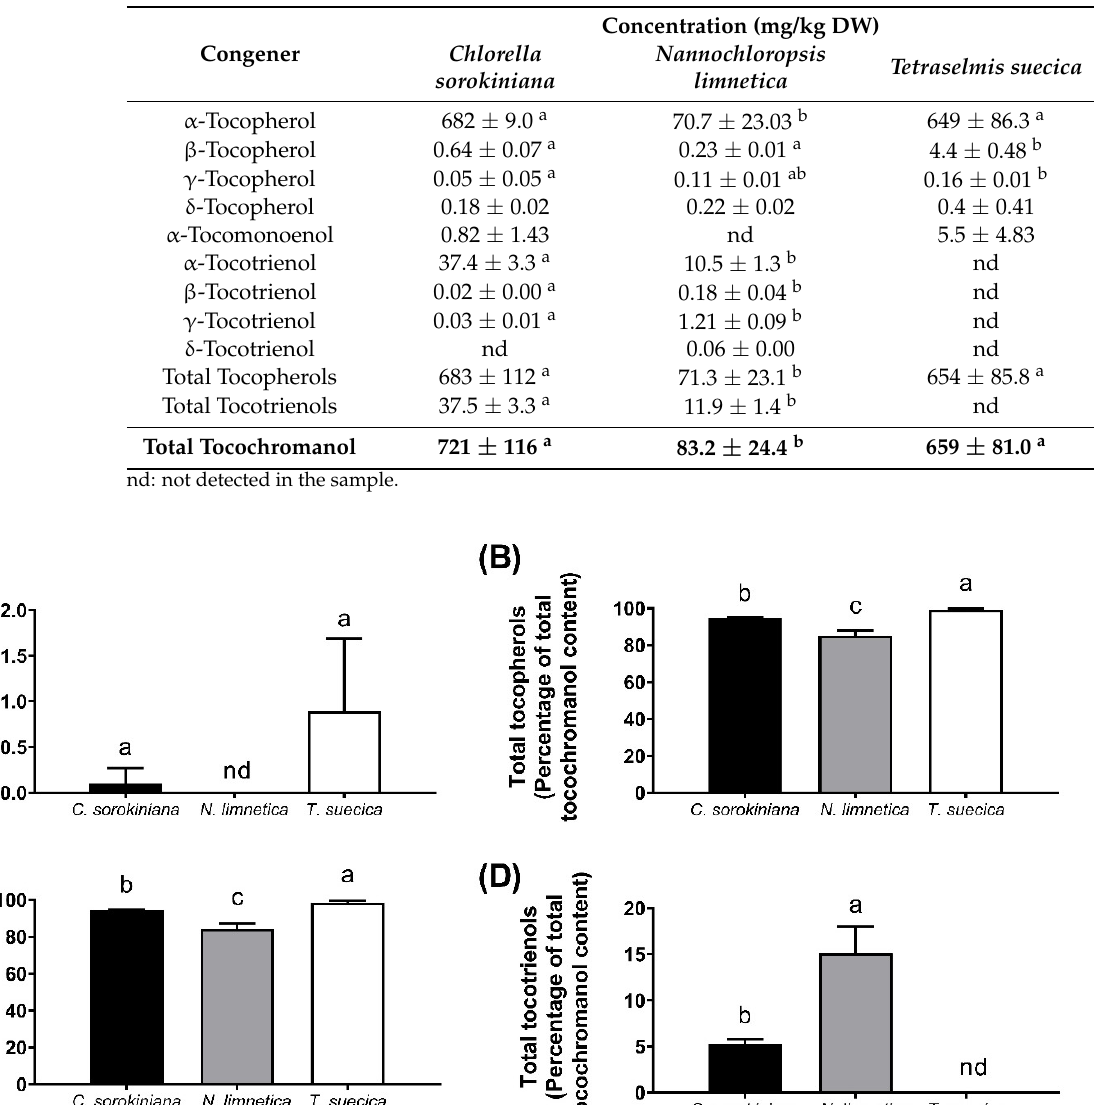
Table 2. Tocochromanol profiles of Chlorella sorokiniana , Nannochloropsis limnetica , and Tetraselmis suecica determined by HPLC-FLD. Values are arithmetic mean ± standard deviation; n = 6. Congeners not sharing a superscript letter are significantly different (ANOVA, α = 0.05).